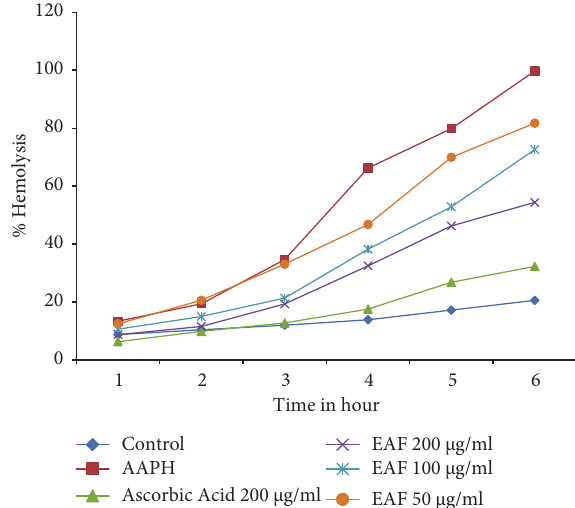
Figure 1: Time course effect of EAF and ascorbic acid on AAPH-induced hemolysis on erythrocytes. Values are expressed as mean ± SD of three experiments.